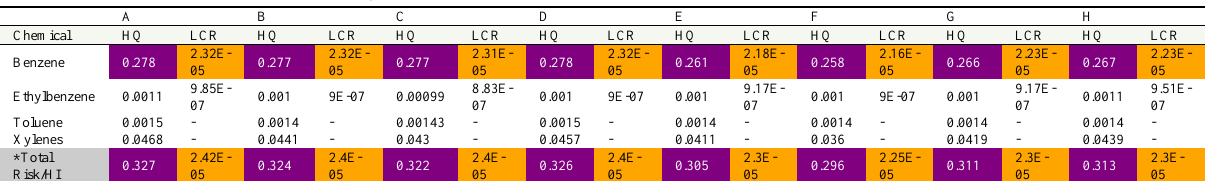
Table 5. LCR and HQ of BTEX compounds